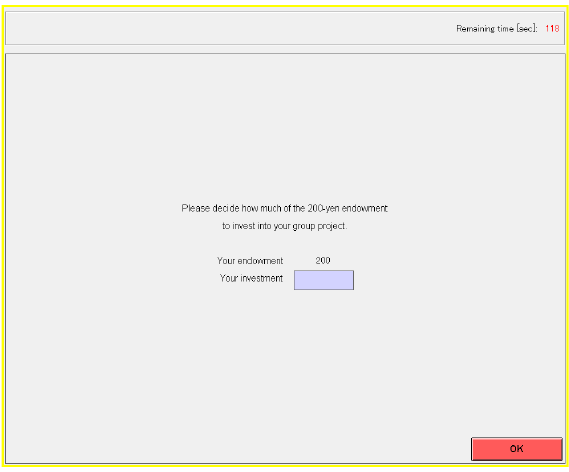
Figure A3. Computer screen for Task 2.